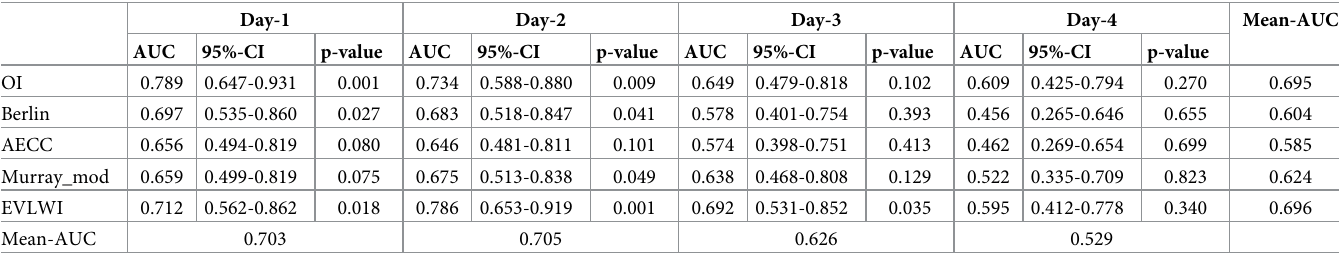
Table 5. Prediction of 28-days-mortality by OI, Berlin-, AECC-definition, Murray-score and EVLWI: Patients with PiCCO-monitoring on all four days (d1-d4).